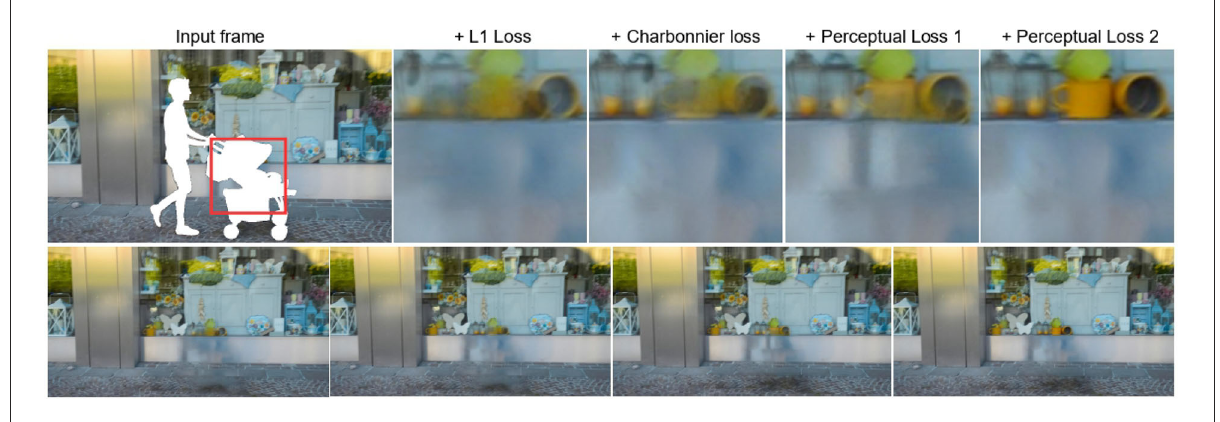
FIGURE6 Effects of inpainting under different loss